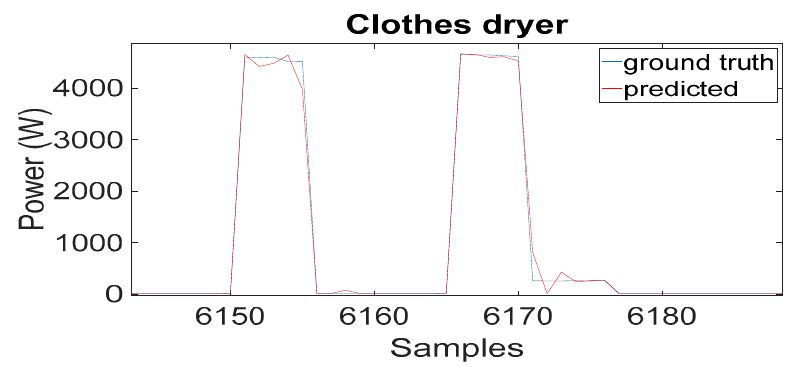
Figure 10. Clothes dryer AMPD: blue, ground truth active power; red, estimated active power.